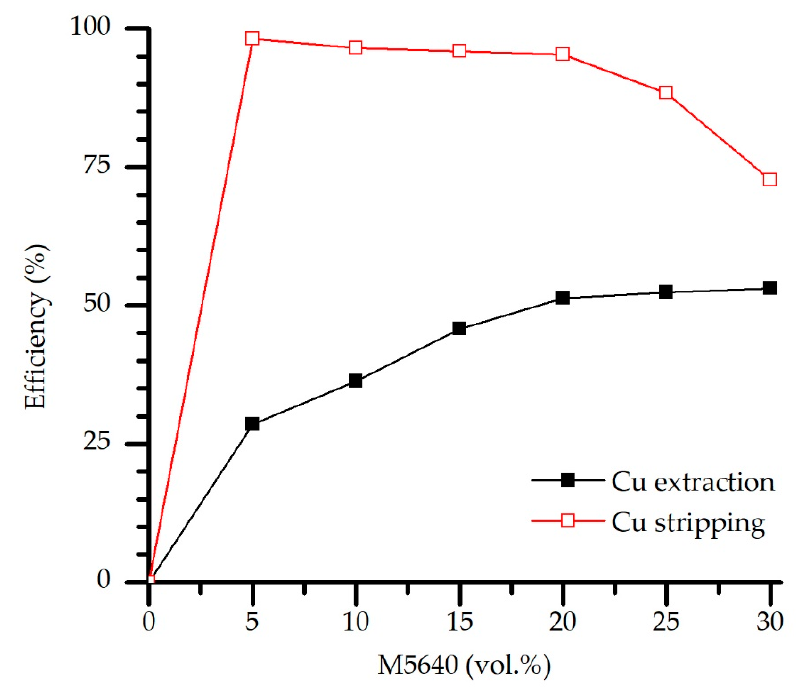
Figure 10. Extraction-stripping efficiency correlation—effect of the extractant concentration in the loaded OP on the stripping efficiency (H 2 SO 4 180 g/L, O/A = 2, contact time 5 min).